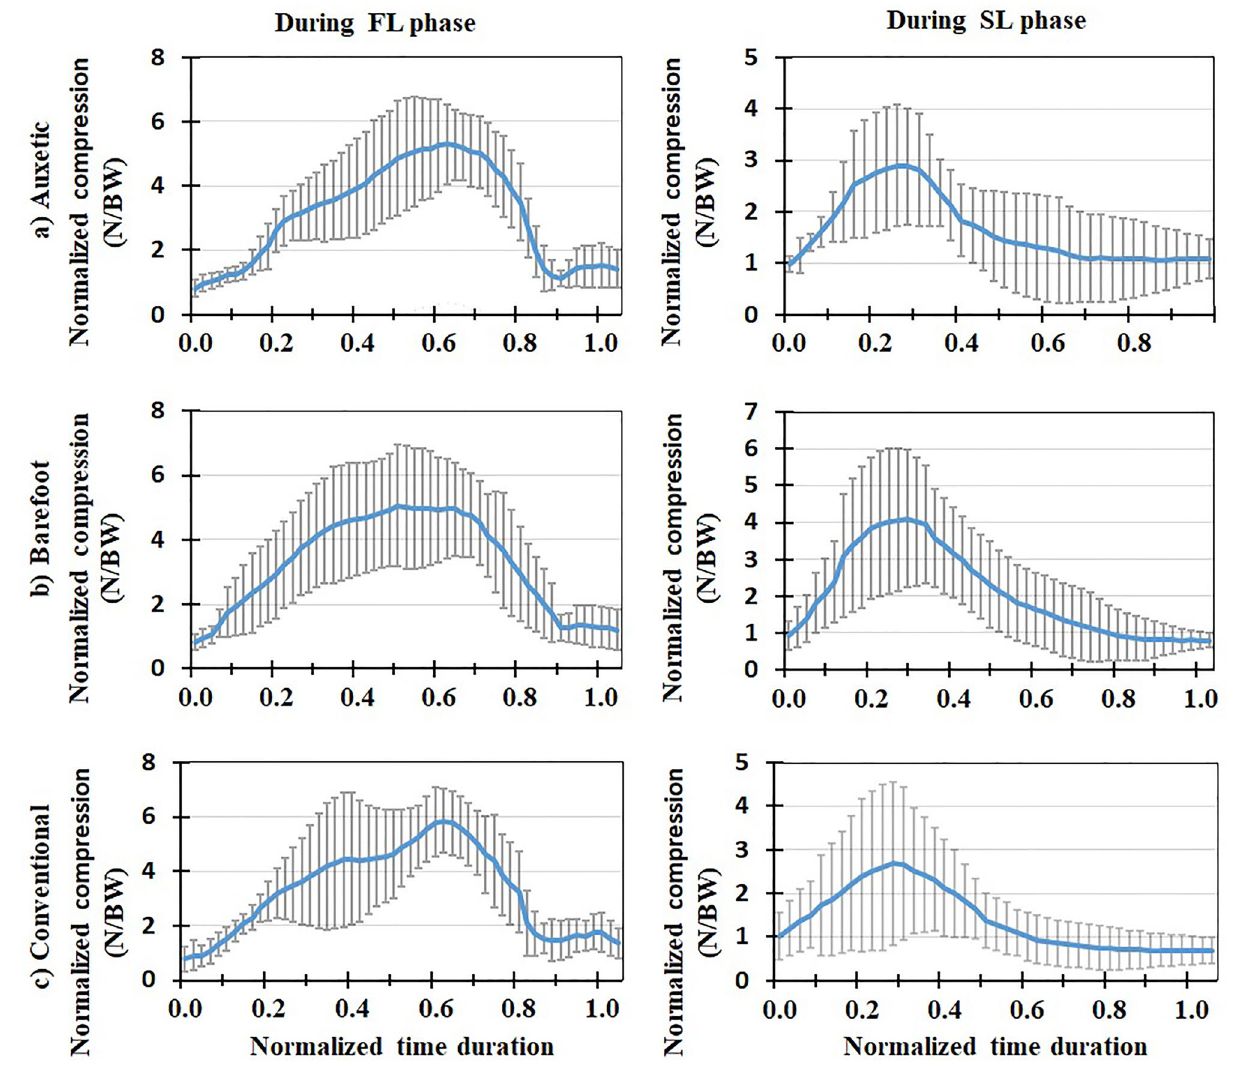
Figure 4. Mean normalized lumbosacral (L5-S1) compression force (N/BW) for all the participants (+ / − one standard deviation) in three footwear conditions: ( a ) auxetic shoe, ( b ) barefoot, and ( c ) conventional shoe. Left and right plots indicate variations during FL and SL phases of DVJ,